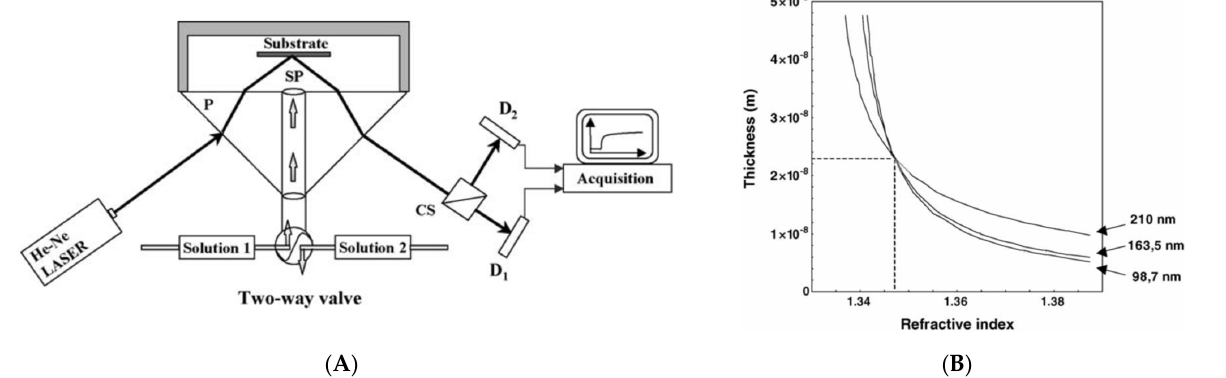
Figure 7. ( A ) Schematic of optical fixed-angle reflectometry and ( B ) graphical determination of mean refractive index and thickness of PVI monolayer originated from Ref. [47]; SP, stagnation point; P, prism; D 1,2 , photodiodes; CS, polarizing beam splitter